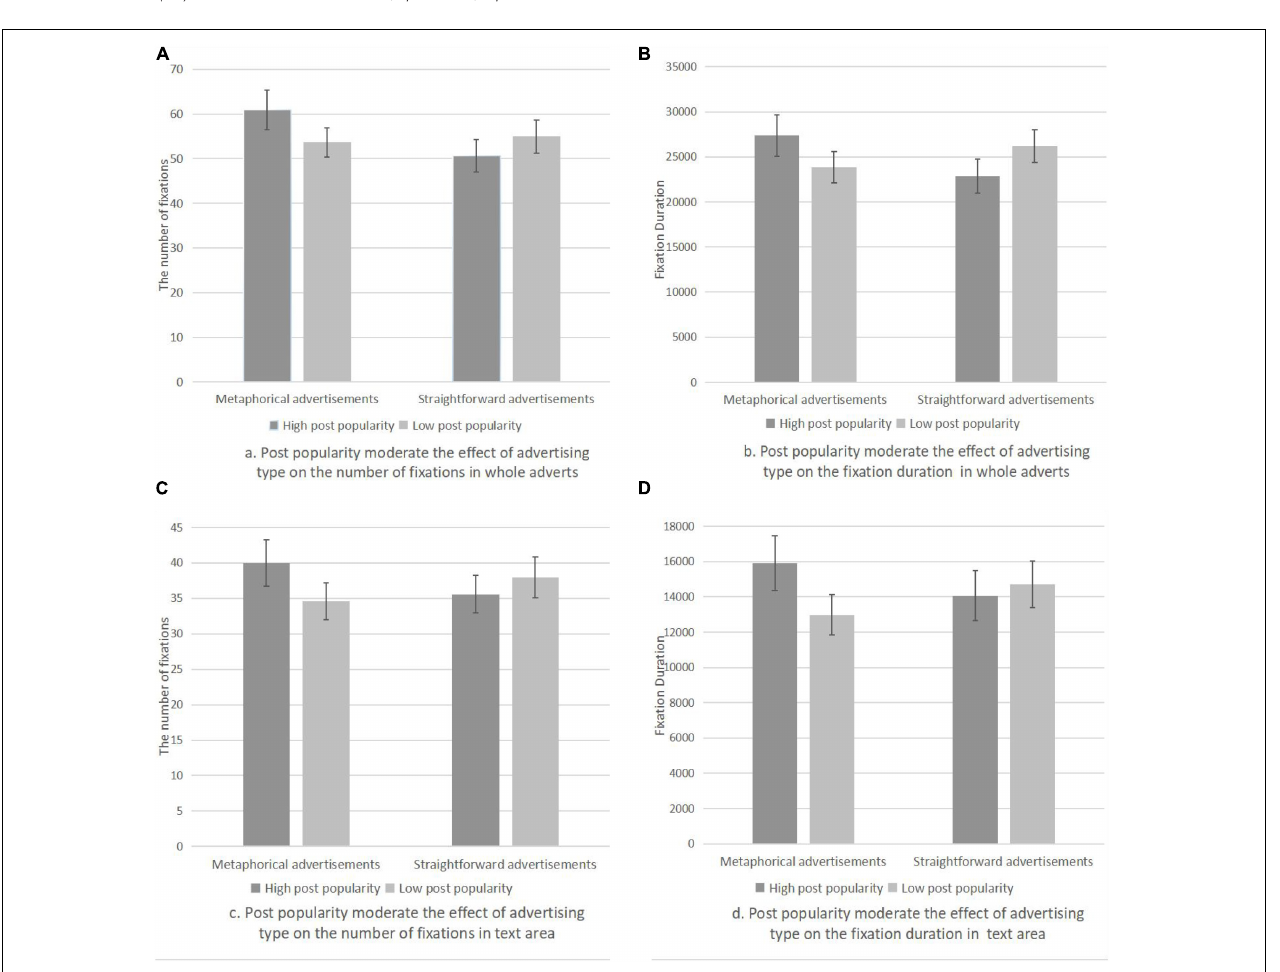
FIGURE 2 | Peripheral cues moderate the effect of advertising types on visual